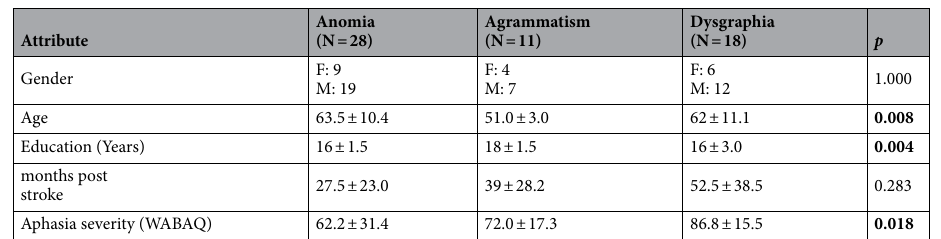
Table 2. Subject demographics and WABAQ by language-specific deficit. Counts by attribute and aphasia impairment are shown for categorical variables. Categorical variable p values are calculated with a two-sided Fisher’s Exact Test. For continuous variables, median ± median absolute deviation is shown. Continuous variable p values are calculated with a Kruskal–Wallis one-way analysis of variance. Significant p values are bolded ( p < 0.05).